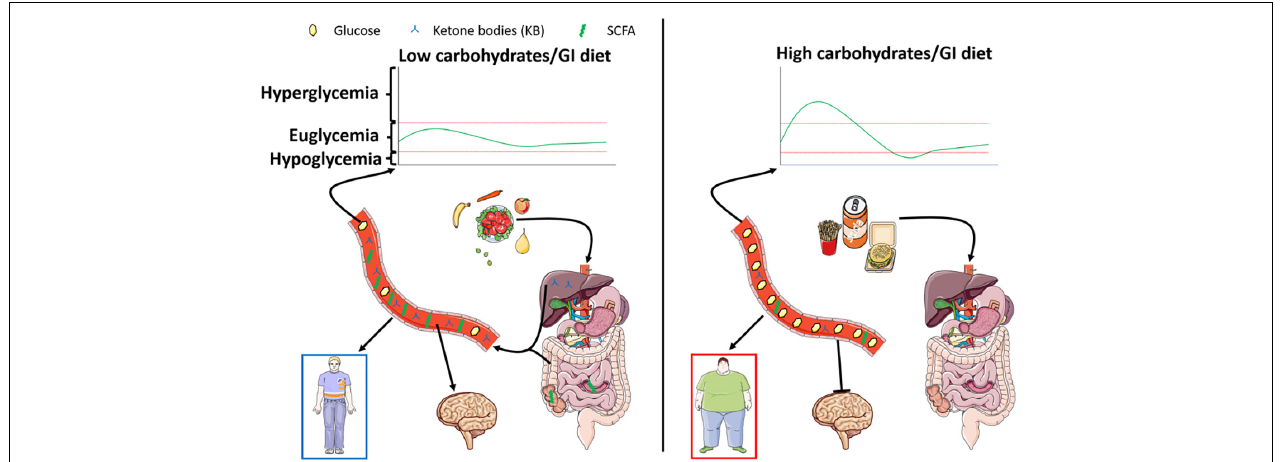
FIGURE 2 | Left panel represents the effect of a low carbohydrate/glycemic index diet known for its beneficial impact on energy homeostasis. The low levels of digestible sugars are responsible for increased SCFA produced within the gut, paralleled by stimulated lipid oxidation le a ding to the production of ketone bodies. Both nutrients exhibited a putative beneficial role on metabolism and brain function leading to the prevention of cognitive deficits. On the other hand, represented in the right panel, a high carbohydrate/glycemic index diet will favor obesity and associated metabolic disorders. Interestingly, such diets dampen the production of ketone bodies and SCFA and are associated with decreased cognitive